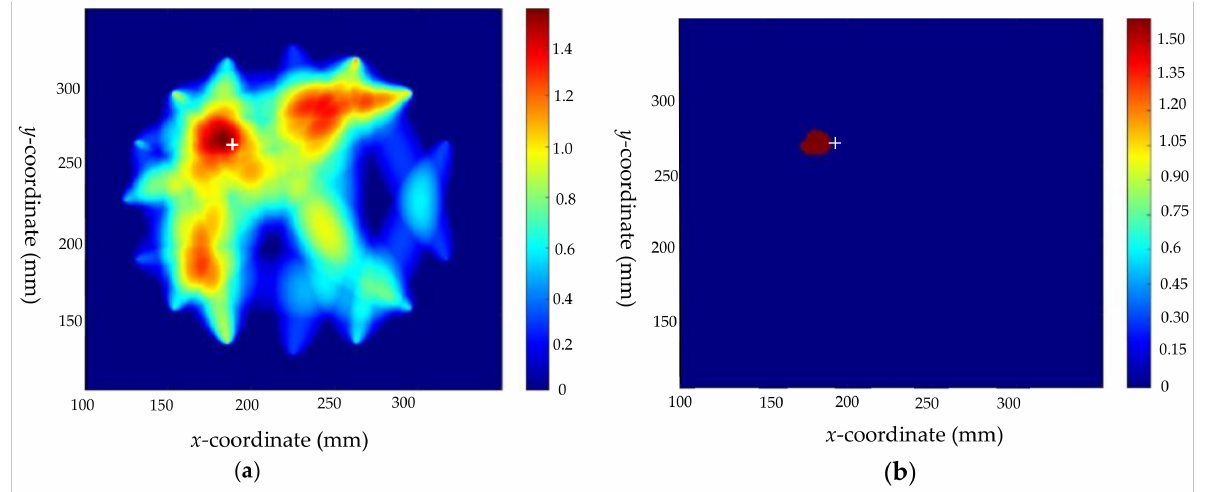
Figure 9. Imaging results before optimization of defect 1: ( a ) before optimization; and ( b ) threshold processing result before